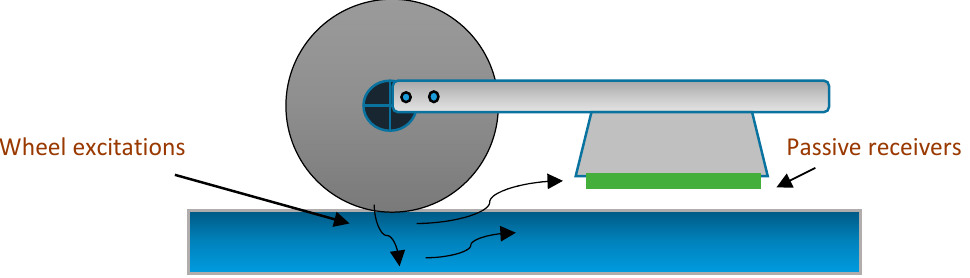
Figure 12. The passive inspection prototype for the field tests using non-contact air receivers .